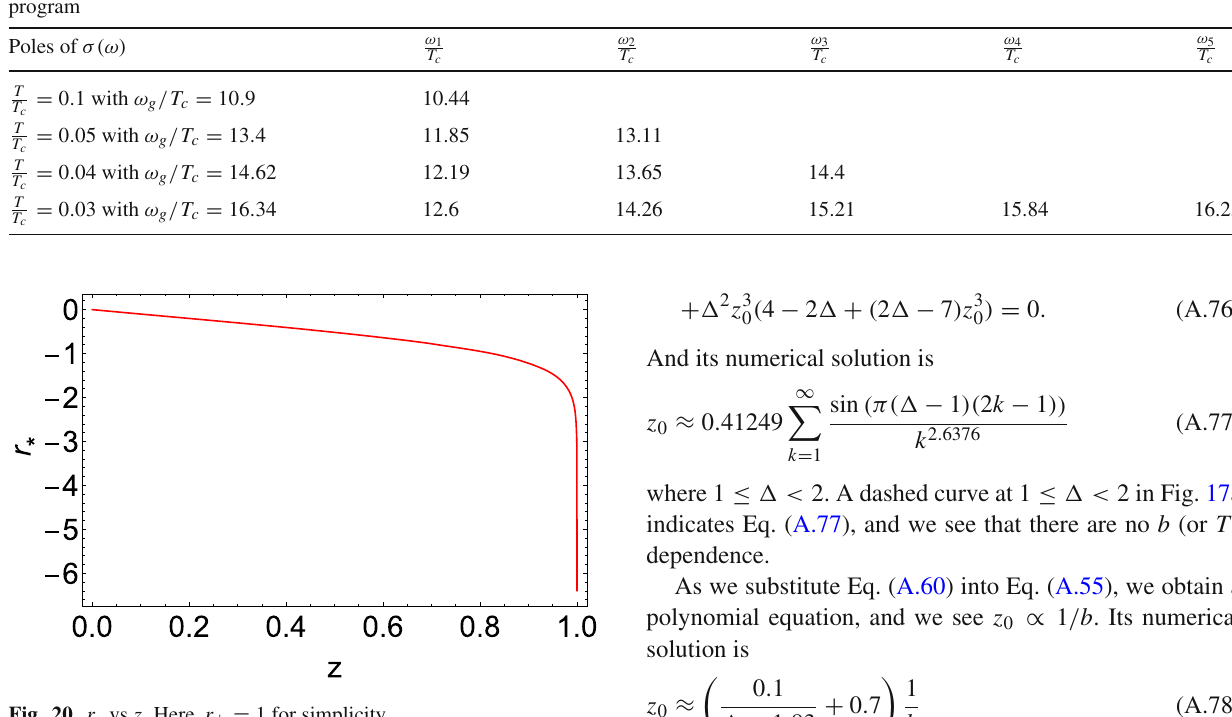
Fig. 20 r (cid:23) vs z . Here, r + = 1 for